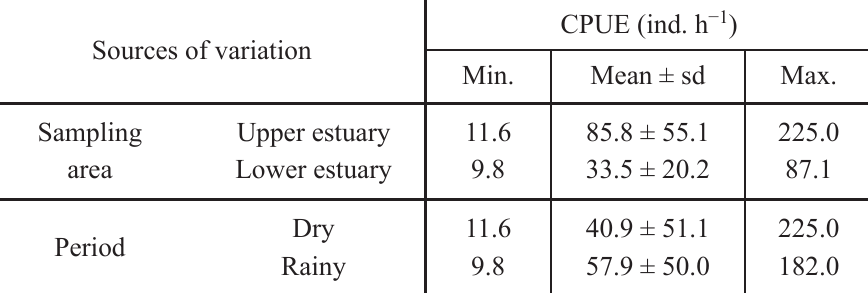
Callinectes danae . Minimum, mean and maximum values of catch per unit effort (CPUE = # of individuals per hour) by sampling area and collection period at the Santa Cruz